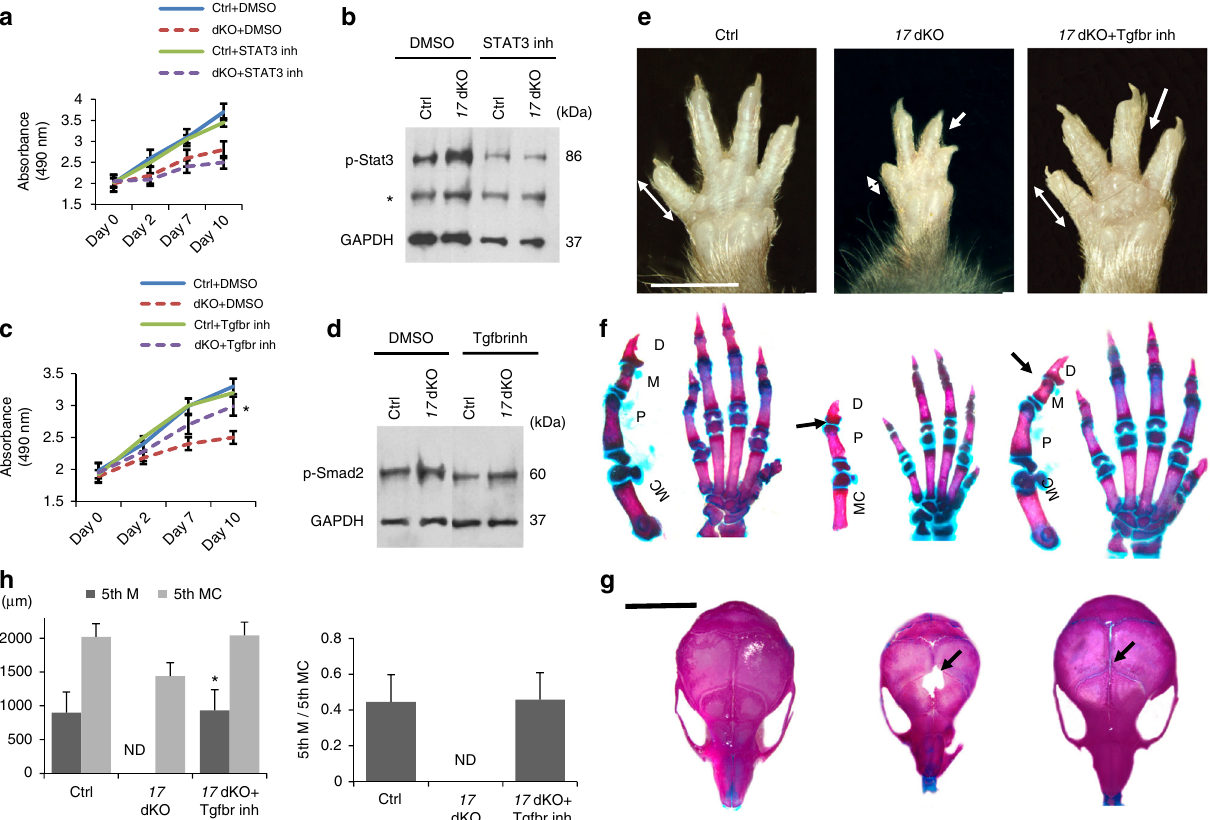
Fig. 4 Rescue of cell proliferation defects with TGF- β receptor inhibitors. a Cell proliferation assay on control (Ctrl) and Mir17-92:Mir106b-25 -de fi cient ( 17 dKO) limb bud mesenchymal cells treated with vehicle (DMSO) or a STAT3 inhibitor (STAT3 inh, S31-201, 100 µ M). Ctrl and 17 dKO limb bud cells were prepared by transducing YPF (Ctrl) or Cre ( 17 dKO) in vitro. STAT3 inhibitor treatment shows no signi fi cant improvement in 17 dKO cell proliferation. b Treatment of limb bud cells with S31-201 downregulates the p-Stat3 level; *non-speci fi c band. c Cell proliferation assay on Ctrl and 17 dKO (dKO) cells treated with DMSO or a TGF- β receptor inhibitor (Tgfbr inh, Ly364947, 0.2 µ M). Treatment with Ly364947 has no signi fi cant effect on control cells whereas it signi fi cantly ameliorates the proliferation defect of 17 dKO cells ( n = 6, * p < 0.05 vs. 17 dKO + DMSO). d Treatment of limb bud cells with Ly364947 downregulates the p-Smad2 level. e – g Ly364947 treatment ef fi ciently rescues the skeletal defects of 17 dKO mutants. Ly364947 (1 mg/kg/day, i.p.) was injected into pregnant and nursing mothers from E9.5 through P7.5, and then injected directly into individual mice. The shortening of the fi fth digit (double arrows) syndactyly (white arrows) ( e ), missing middle phalanx (M) ( f ), and microcephaly and frontal bone ossi fi cation defect (black arrows) ( g ) in 17 dKO mutants were ameliorated by Ly364947 treatment. h Quanti fi cation of the length of the fi fth mesophalanx (5th M), fi fth metacarpal bone (5th MC), and the ratio of 5th M to 5th MC. Values are expressed as mean ± SE ( n = 6 each group, p < 0.001 vs. dKO). Scale bars: 0.5 cm in e , 1.0 cm in g . D distal phalanx; P proximal